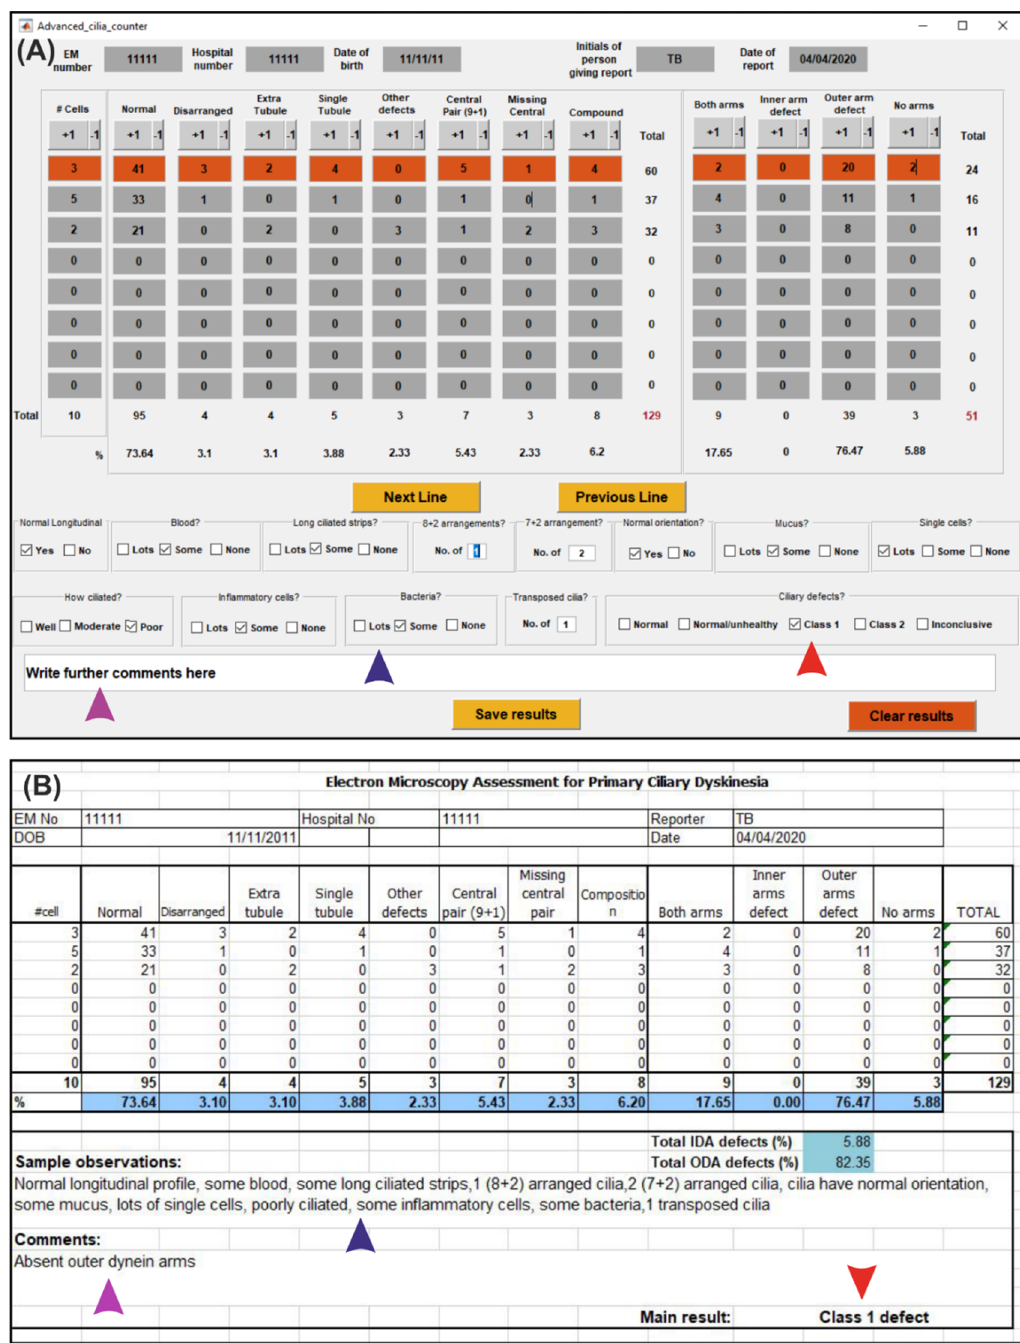
Figure 5. Advance counter that includes samples notes and an example of an Excel sheet that is generated when saving the results. ( A ) The number of features is tallied up by inputting numbers or by pressing the +1 or − 1 buttons. The description of key features is inputted by pressing the checkboxes. ( B ) Excel sheet generated by the counter, which includes the counts of each type of feature and a description of the sample. The information entered by pressing the checkboxes in the counter populates a description in the Excel sheet (blue arrowhead in A and B ). The ciliary defect class and comments about the sample are automatically transferred from the counter to the Excel sheet (red and purple arrowheads in A and B respectively).